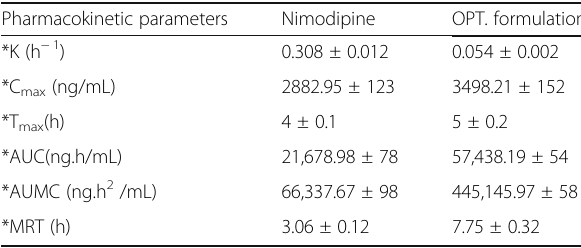
Table 7 Determination of in vivo pharmacokinetic parameters Pharmacokinetic